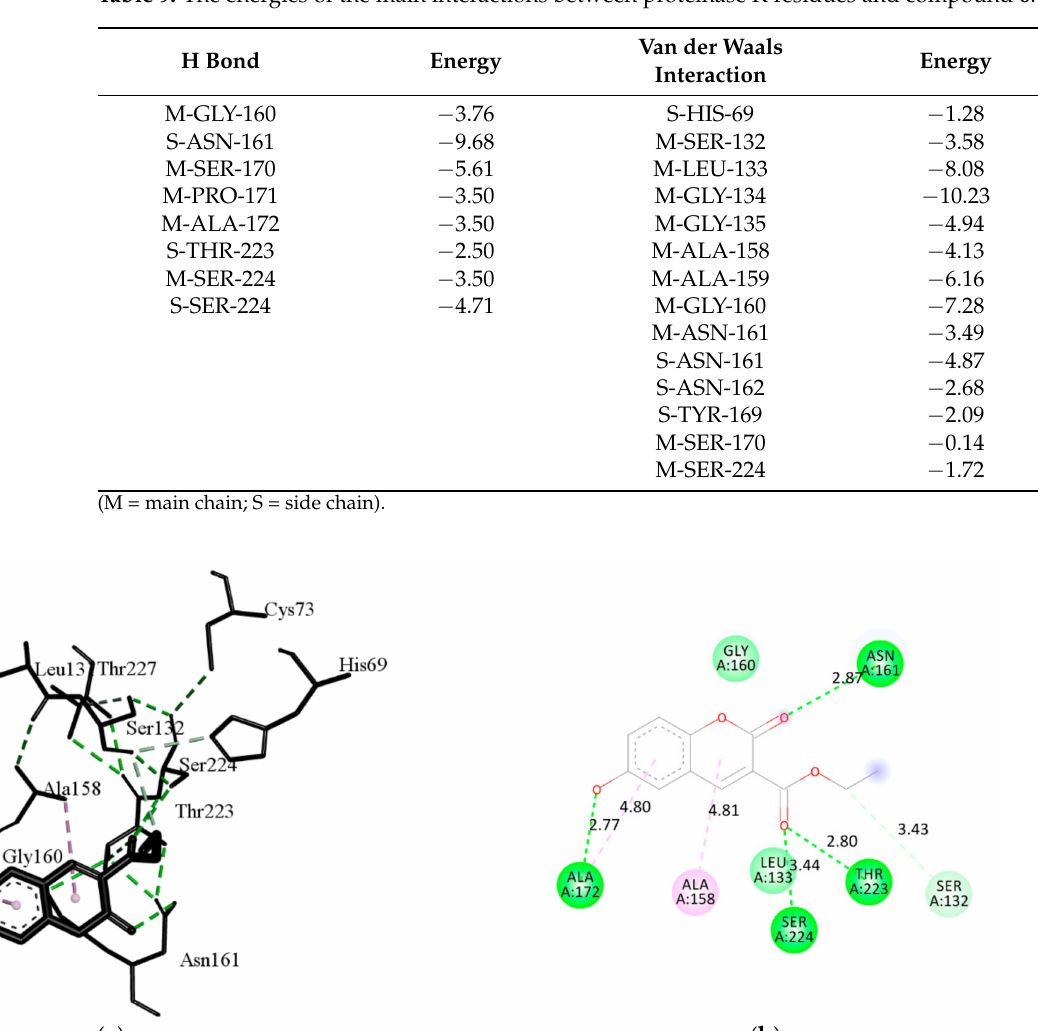
Table 9. The energies of the main interactions between proteinase K residues and compound 6 .